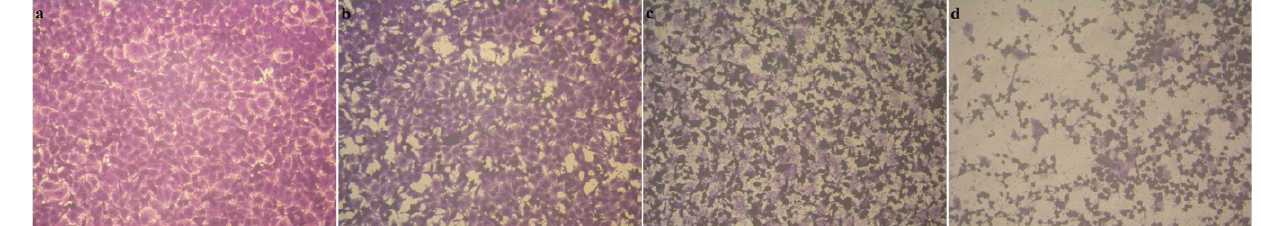
Figure 8. Morphological alterations of ovarian adenocarcinoma cell line (SKOV-3) treated with synthesized TiO 2 nanoparticles concentrations for 24 h ( a ): Control; ( b ): 20 μ g/mL; ( c ): 100 μ g/mL; ( d ): 500 μ g/mL. 100 x .